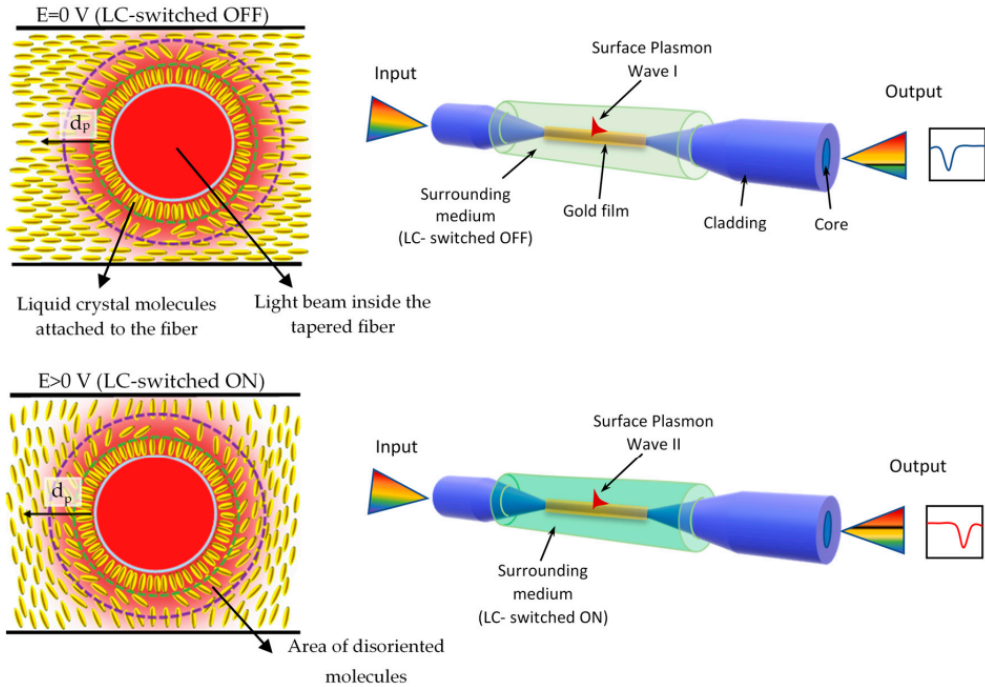
Figure 3. Surface plasmon resonance (SPR) e ff ect in the optical fiber taper-based